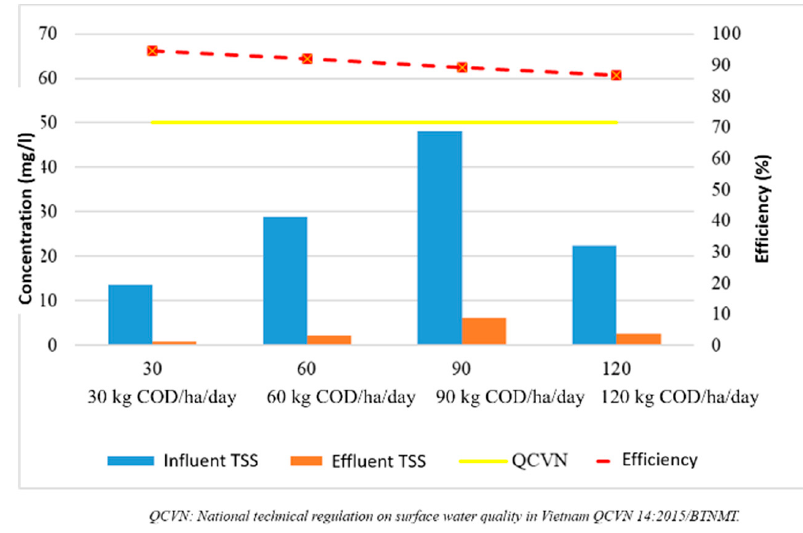
Figure 4. Effect of organic loading on TSS removal efficiency.